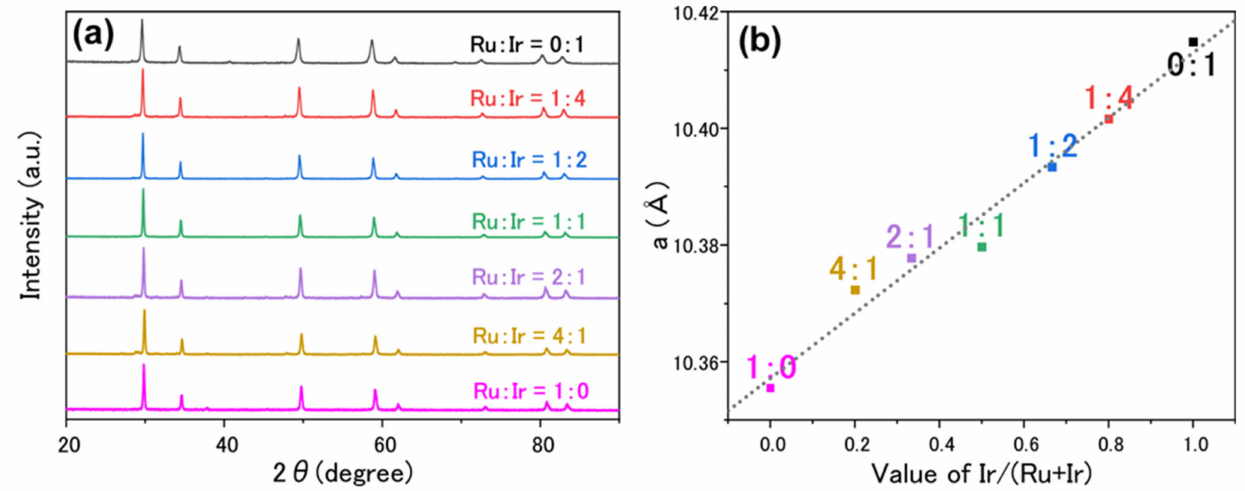
Figure 2. ( a ) Experimental XRD patterns of Pr 2 (Ru x Ir 1 − x ) 2 O 7 with different ratios of Ru and Ir. ( b ) Lattice constant a of Pr 2 (Ru x Ir 1 − x ) 2 O 7 plotted against the Ir/(Ir + Ru) molar ratio. The dotted lines serve as a visual